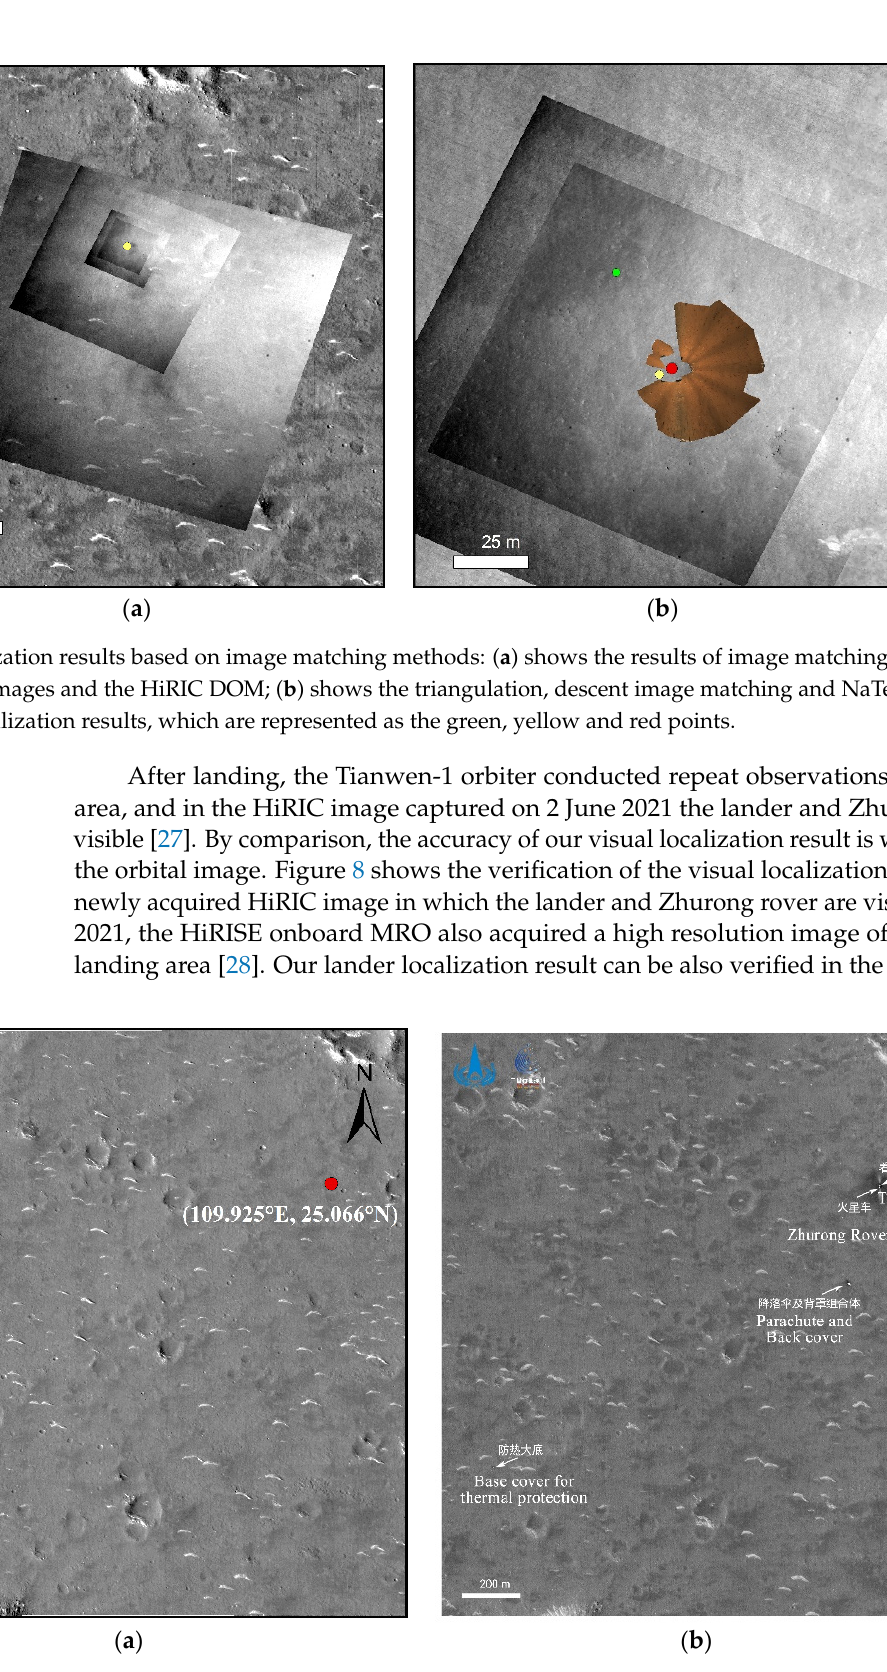
Figure 8. Verification of the localization result with the newly acquired orbital image [21]: ( a ) is the visual localization result; ( b ) is the released orbital image with the visibility of the lander and Zhurong rover.